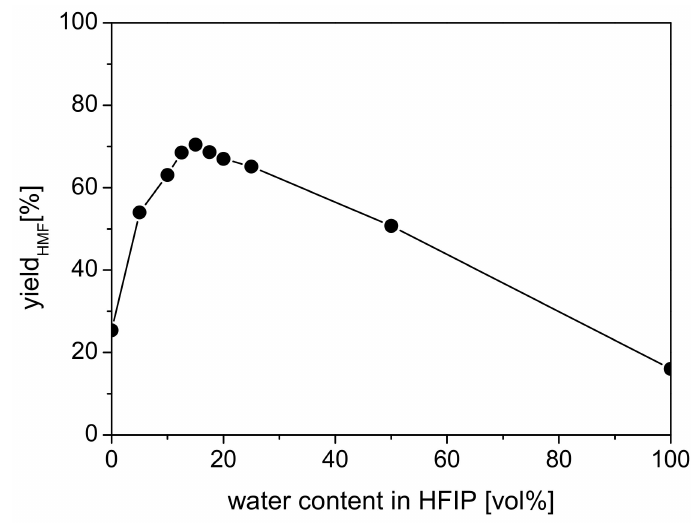
Figure 4. Effect of water content in HFIP on maximum HMF yield. Reaction conditions: 0.5 M fructose,